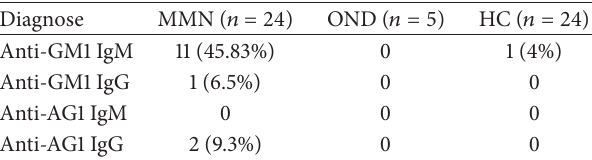
Table 1: ELISA reactivity of tested patient sera with gangliosides.